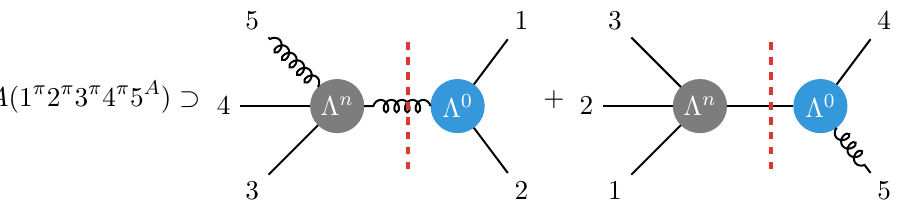
Figure 4 . Generalized unitarity cuts used to constrain BCJ satisfying partial amplitudes con- tributing to A 5 ( ππππA ) . Given the existence of A ( n ) ( ππAA ) at any order O (Λ n ) , an additional 4 four-point all-pion higher-derivative contact is required to maintain double-copy consistency at five- point, such that A ( n ) ( ππAA ) ⇐⇒ A ( n ) ( ππππ ) 4 4